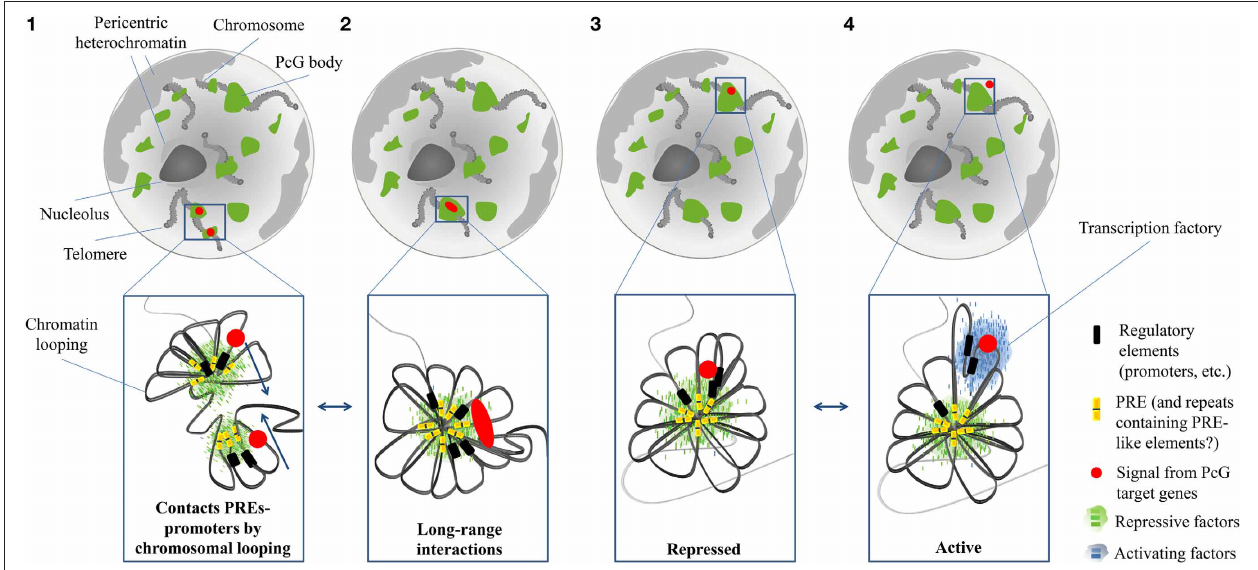
FIGURE 4 | Schematic representation of the distribution and dynamics of Polycomb (PcG) bodies within the nucleus. PcG bodies (green) are hubs where, by chromatin looping, Polycomb Response Elements (PREs; yellow bars) closely interact with promoters (black bars) of PcG target genes (red circles), and where PcG proteins and other repressive factors (small green bars) accumulate, thanks to the binding to PREs (1) . PcG-bound elements and promoters are able to engage long-range chromatin interactions, so that two different PcG bodies cluster into the same structure. Red oval